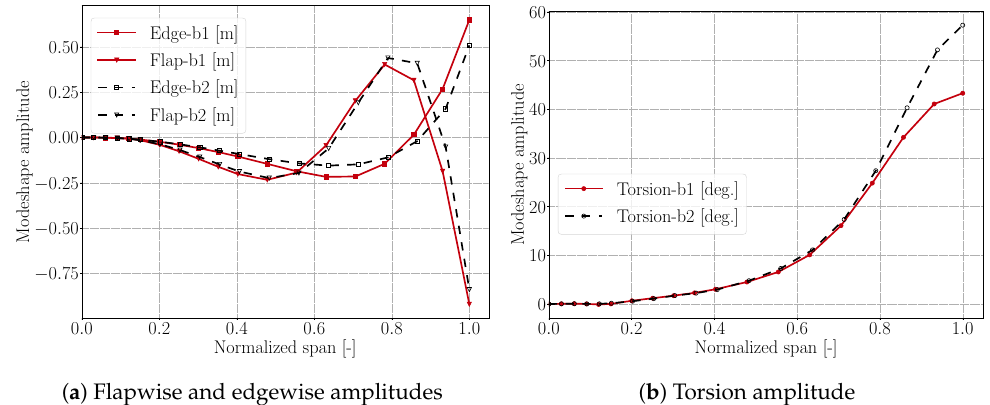
Figure 10. Fourth mode shape flapwise and edgewise shown in ( a ), and torsion amplitudes shown in ( b ) for both blade designs (Blade-1: b1, Blade-2: b2) (structural response only). The coupling between edgewise and torsion motion varies as blades deform in the flap- wise direction. In other words, the edgewise–torsion coupling is a function of the flapwise